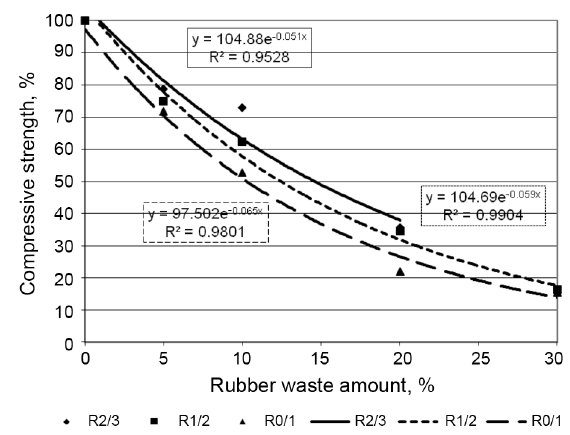
Fig. 4. Effect of CR amount and size fraction on the compres- sive strength of